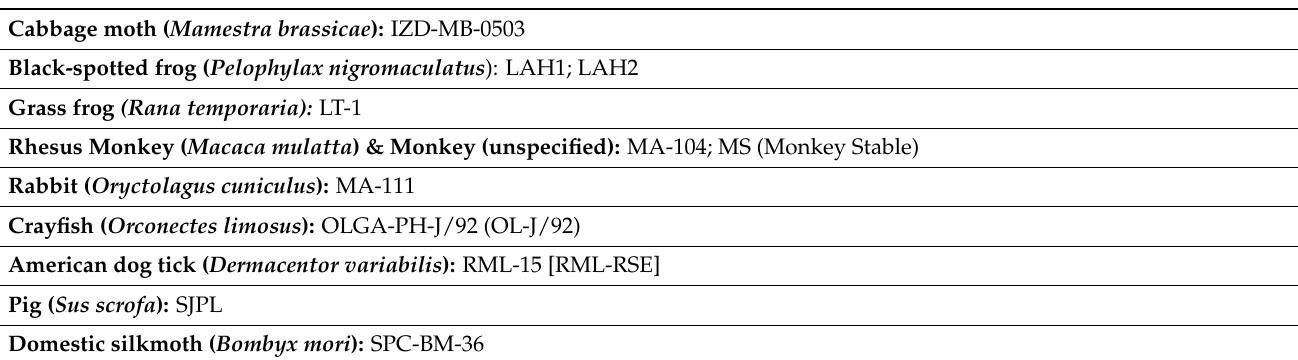
Table 4. Cont. Cabbage moth ( Mamestra brassicae ):